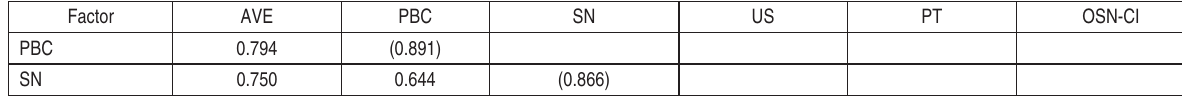
Table 3. Factor AVE and correlation